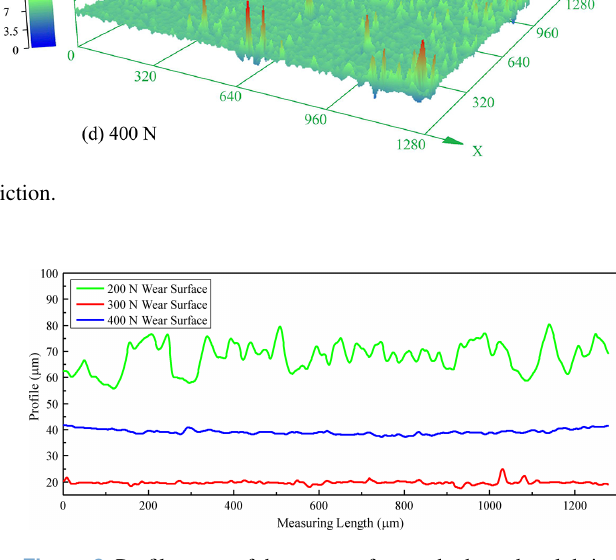
Figure 8. Profile curve of the wear surface under boundary lubrica- tion conditions.